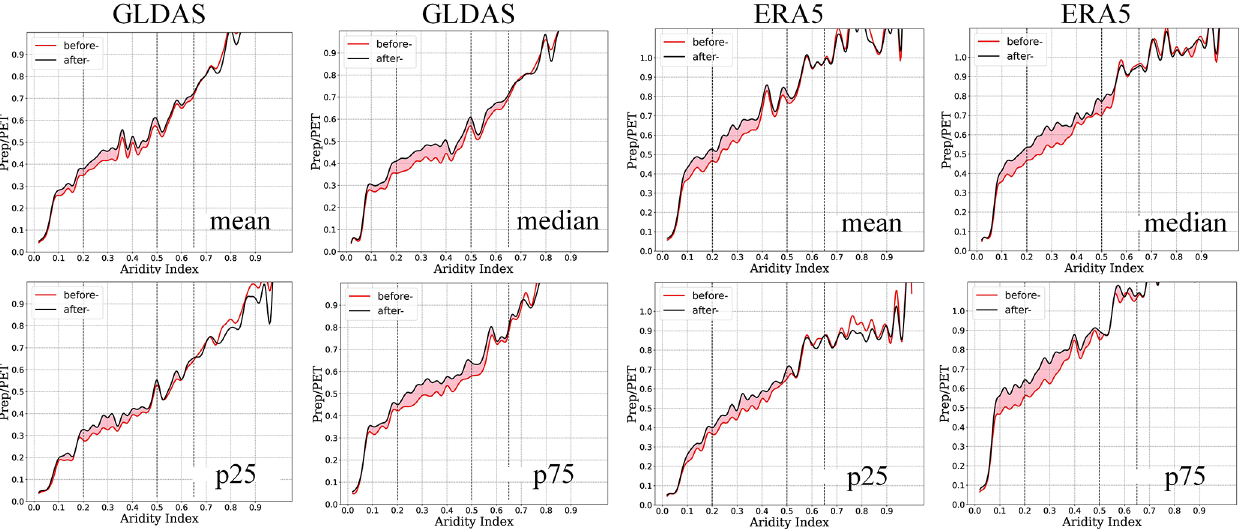
Figure 19. Variations of the Prep/PET statistics (mean, median, 25th quantile (p25), and 75th quantile (p75)) over the summer period (May–September) with the aridity index (AI; Fig. S3) for both cases before (before-) and after (after-) the wetting shift based on GLDAS and ERA5. p25 and p75 are the 25th and 75th quantile of the cumulative distribution of Prep/PET. The pink shaded areas represent the degree of wetting